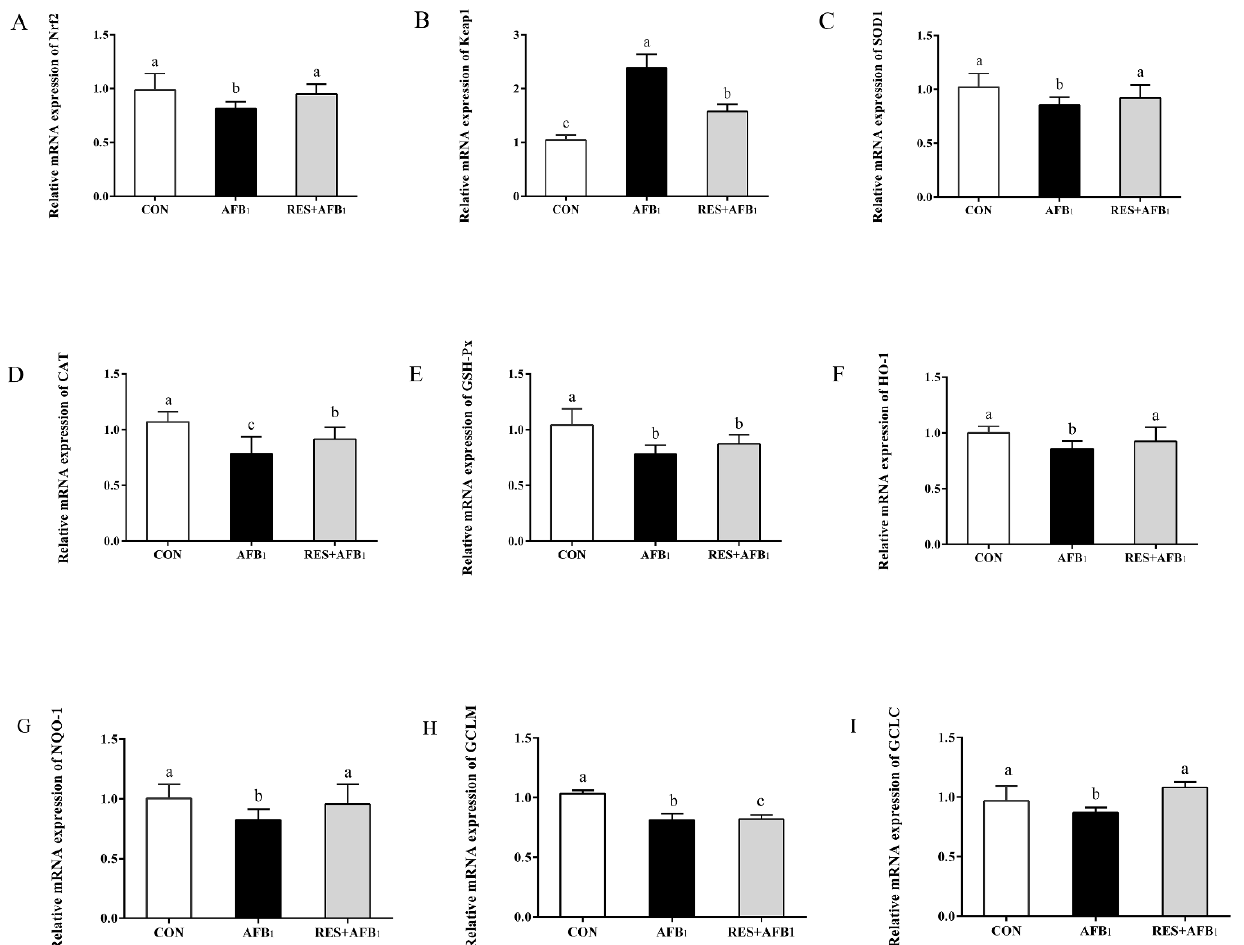
black arrowheads indicate vacuolization of mitochondria. ( C ): Representative photomicrographs of villi in ileum stained with hematoxylin-eosin (magnification, 200×; scale bars, 200 μm). Black arrow- head indicates epithelial denudation and the damaged villi structure. ( D ): (1) The villus height (2) The crypt elongation. Values are expressed as mean ± SD, n = 8. Labeled (a, b, c, a > b > c) means in a row without a common letter differ, p < 0.05.